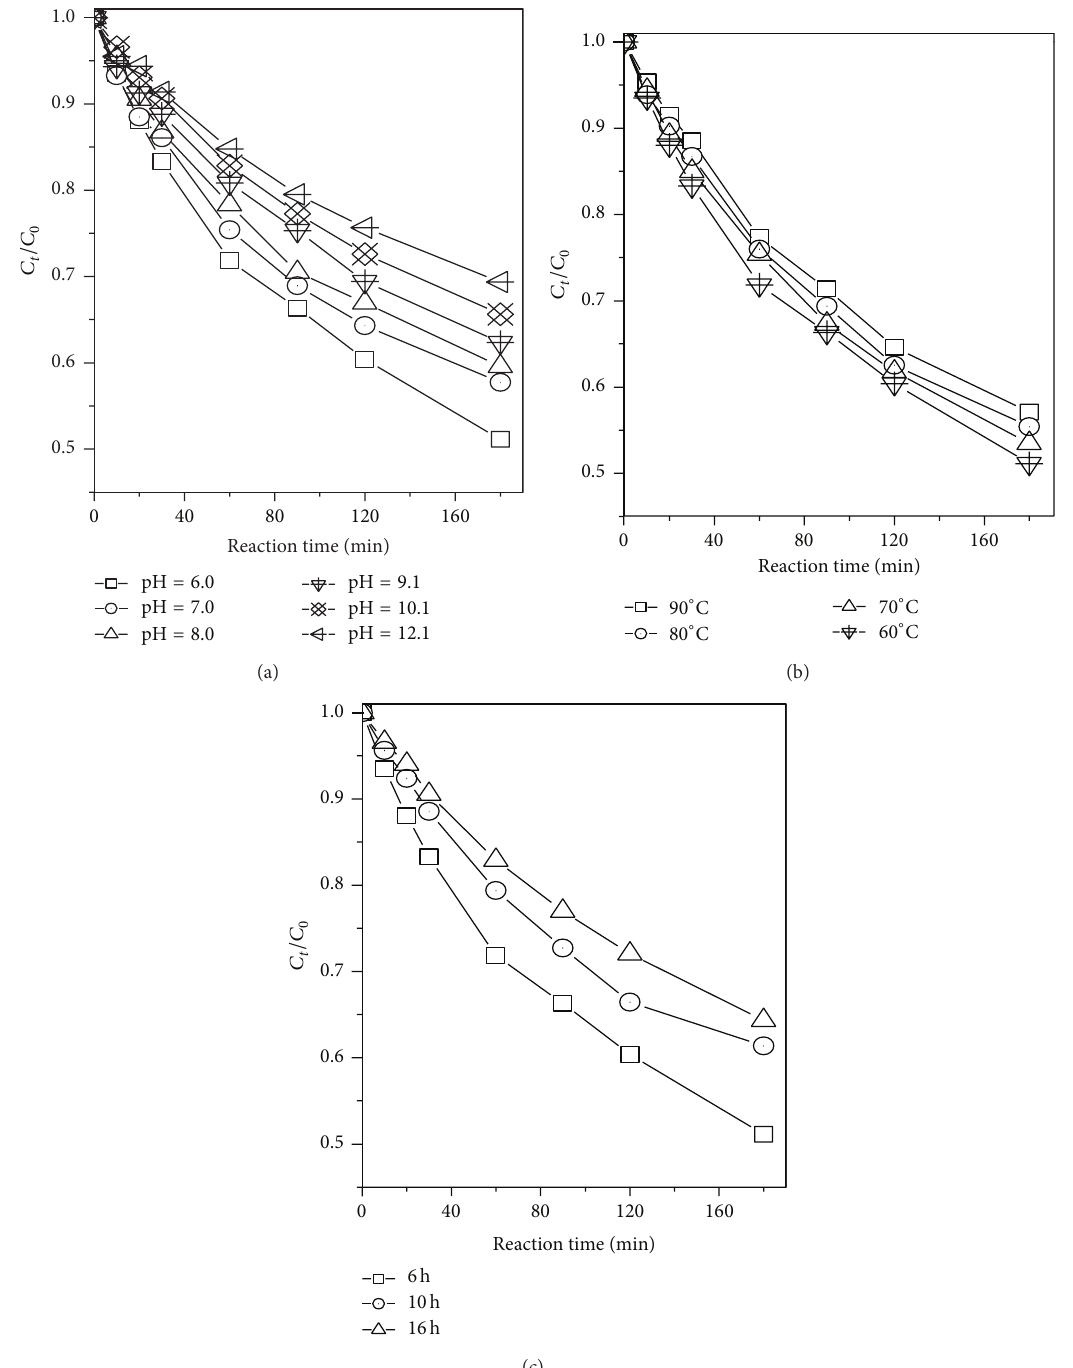
Figure 5: Photocatalytic degradation of Orange I by different 𝛾 -Fe 2 O 3 powders that were prepared under the following conditions: (a) various pH values at 60 ∘ C for 6h; (b) various reaction temperatures at pH of 6.0 for 6 h; (c) various reaction times at 60 ∘ C and pH of 6.0.